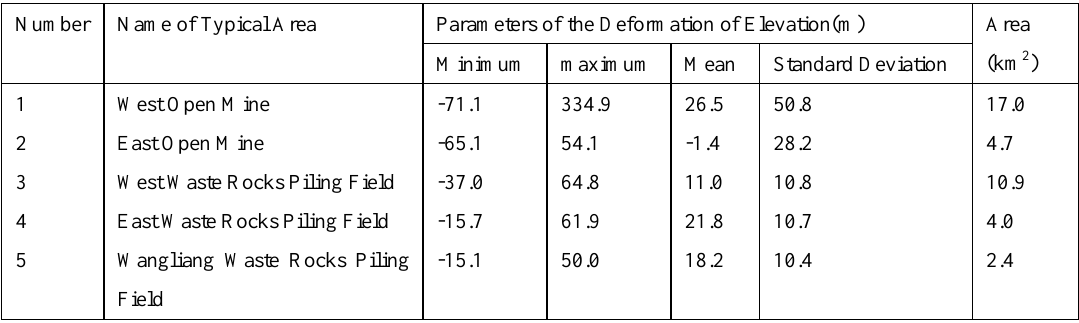
Table 4 Results of the deformation in typical areas with ZY-3 DEM in 2015 and ASTER GDEM.